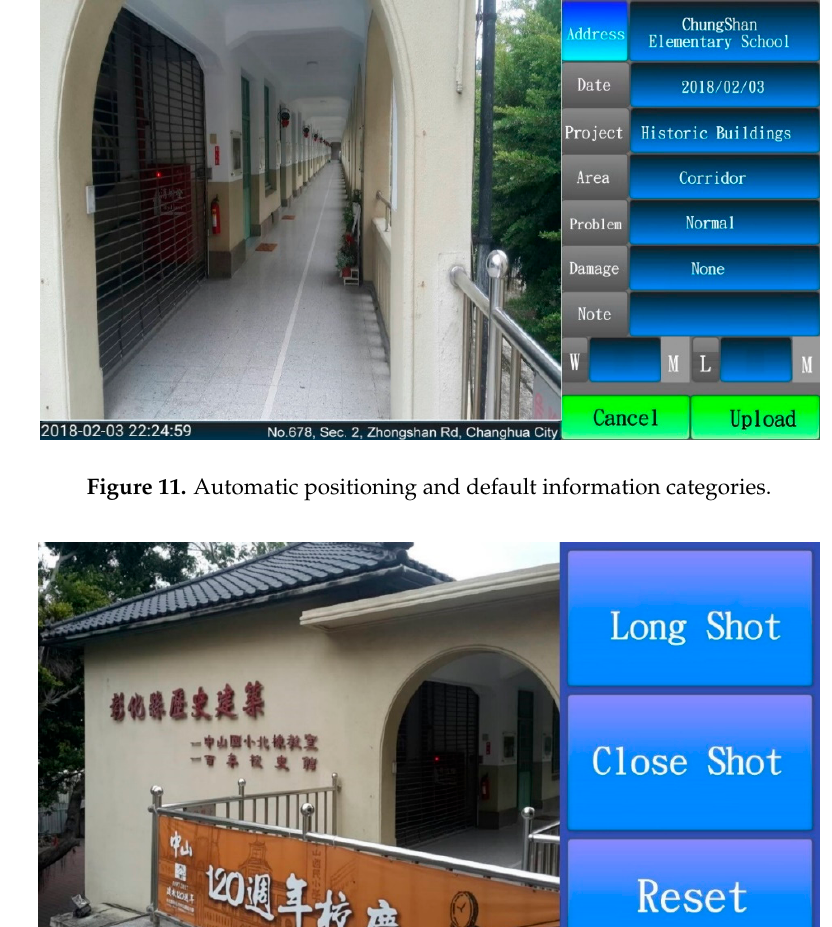
Figure 10. Information maintenance section on the management interface.